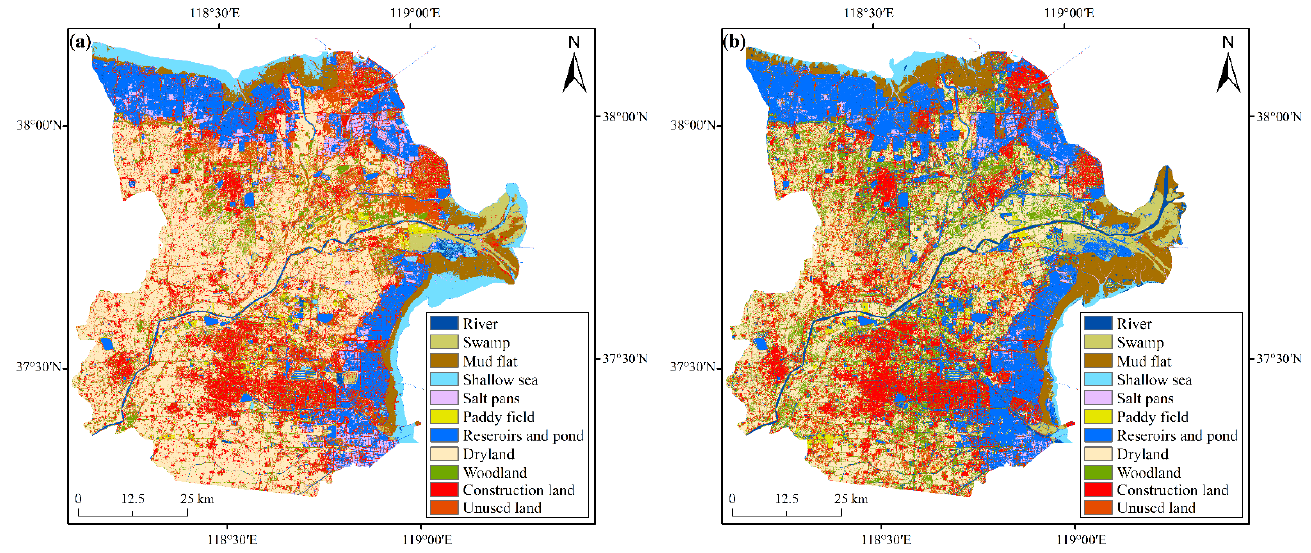
Figure 6. Spatial distribution of wetlands in the YRD: ( a ) 2015; ( b ) 2021.